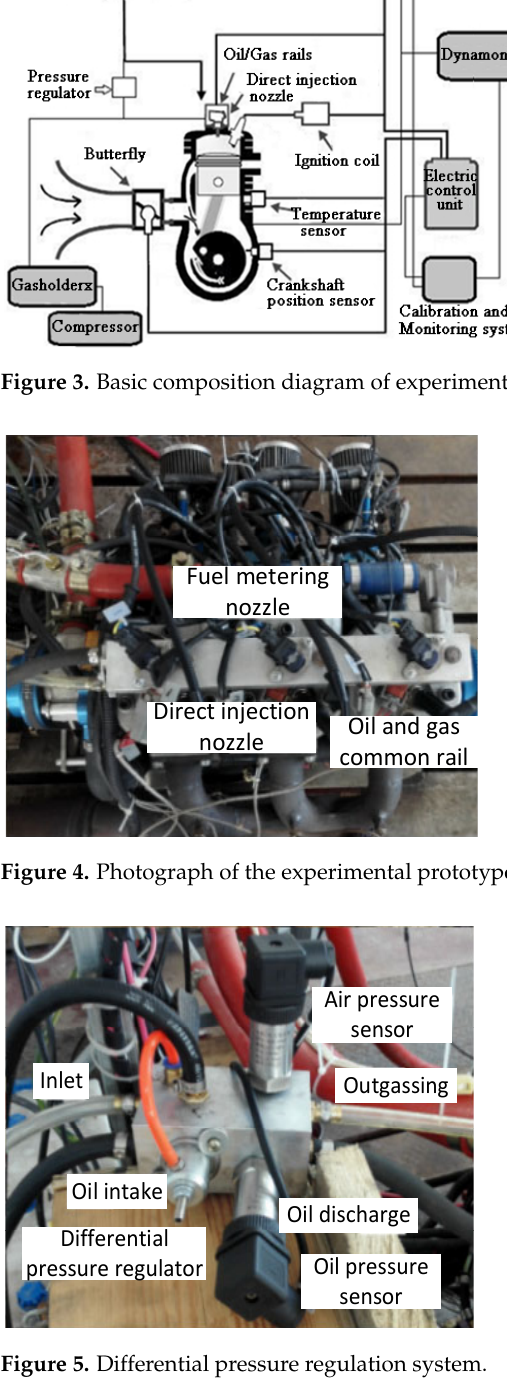
Figure 5. Differential pressure regulation